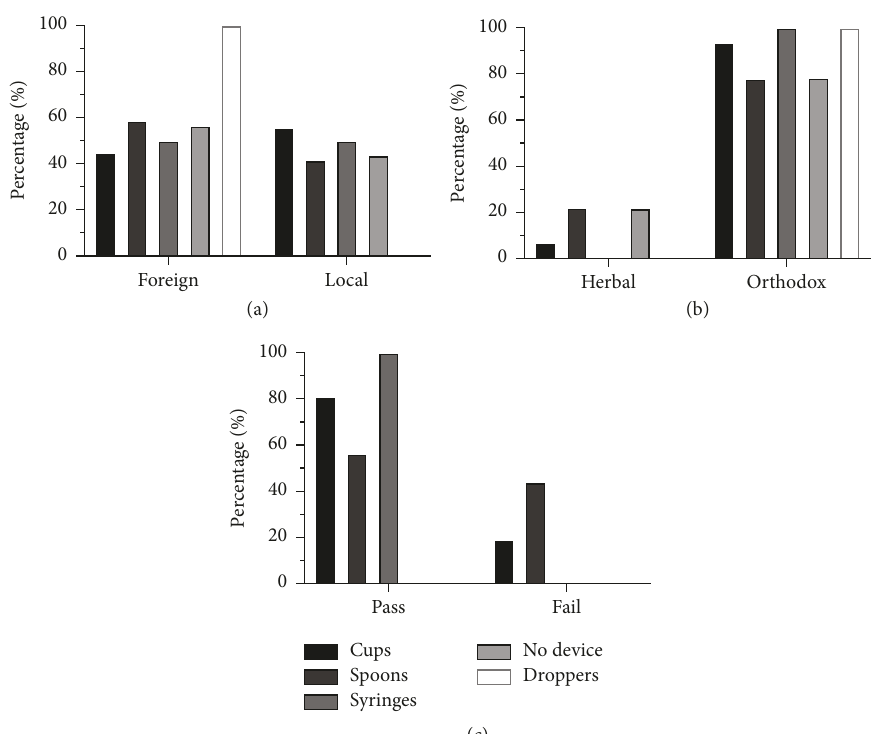
Figure 2: Percentages of dosing devices in terms of (a) country of manufacture, (b) herbal vs. orthodox, and (c) accuracy test according to the